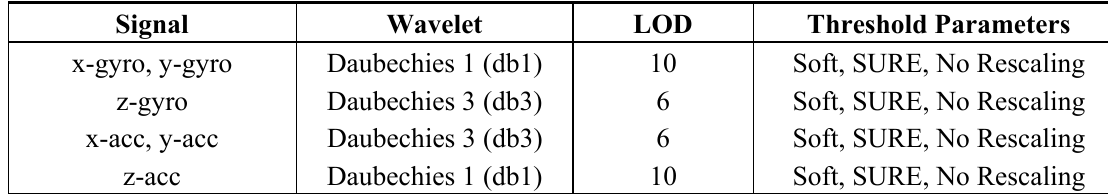
Table 1. Wavelet de-noising parameters.